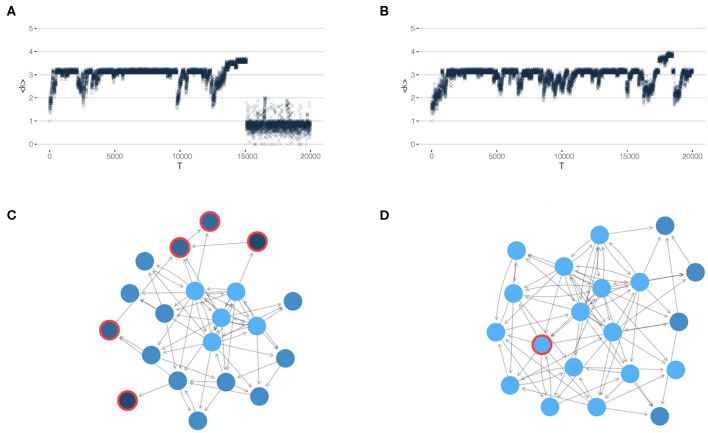
Results of network interventions. (Left) control of many peripheral agents, (Right) control of one agent close to the core. (A,B) show the mean coreness 〈k〉 and the number of agents leaving, Nex over time T, to be compared to Figure 4. (C,D) Snapshots of the network at a particular time T, when the cost c0 of the agents circled in red is adjusted.